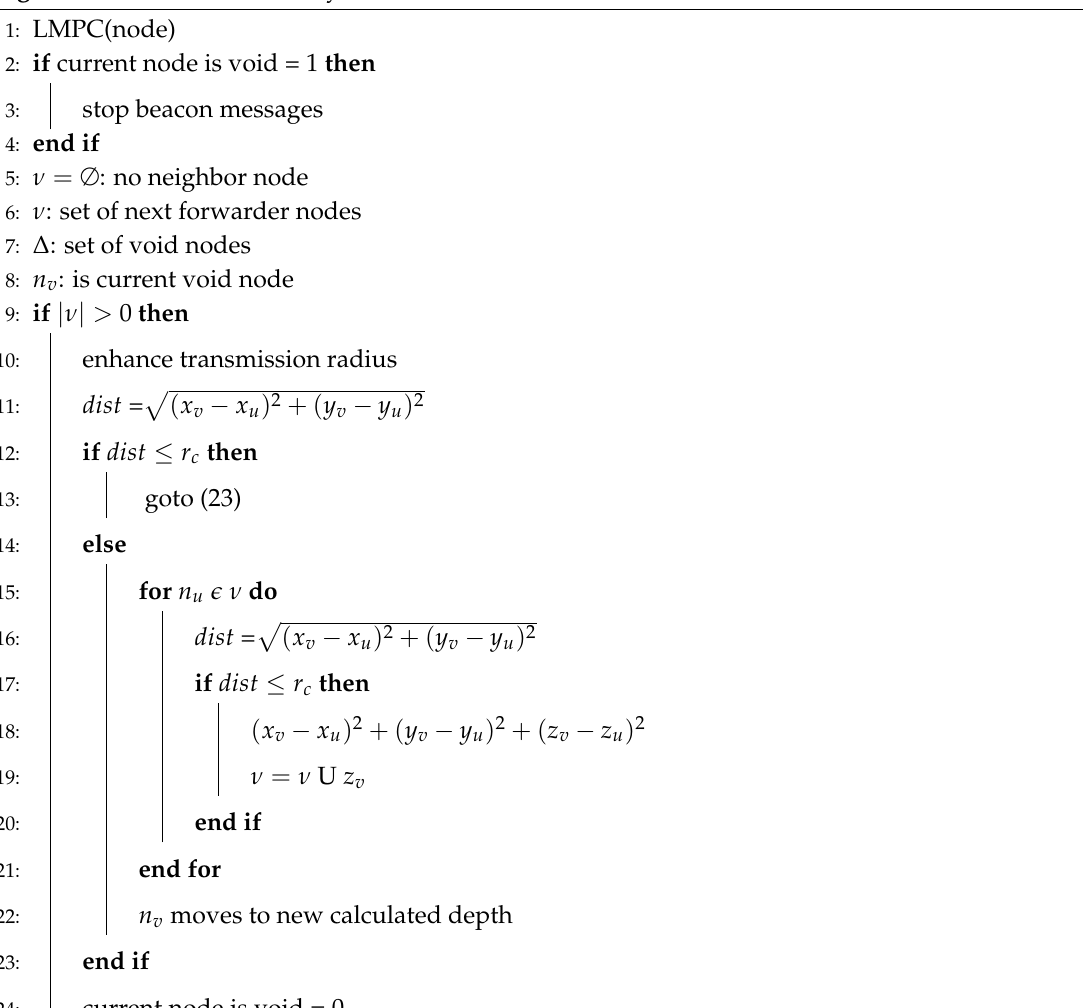
Algorithm 6 Void hole recovery for